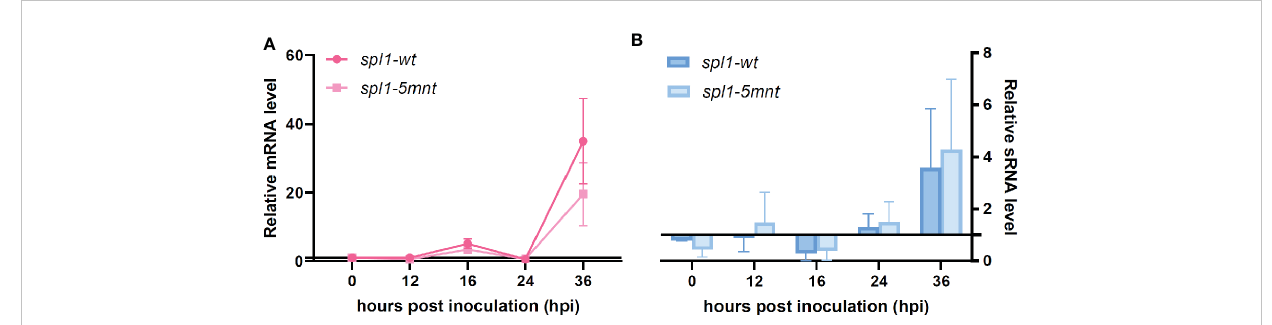
FIGURE 4 Expression levels of Bcspl1 mRNA (A) and sRNA1187 (B) in spl1-wt and spl1-5mnt inoculated tomato leaves during the fi rst 36 hpi. The expression data are shown by mean relative expression levels with standard error, either in a line chart (A) or a bar chart (B) , resulting from four independent inoculation assays.